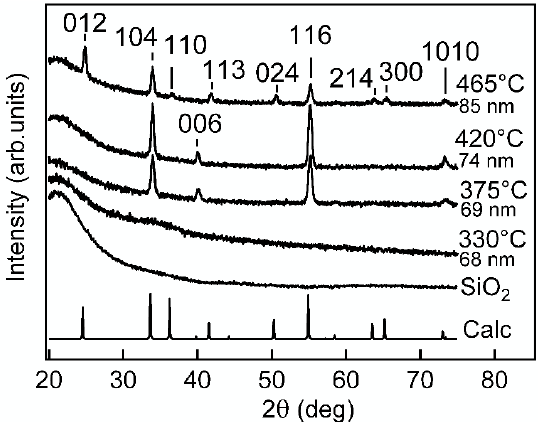
Figure 1. Diffraction patterns of ALD Cr 2 O 3 films grown at different temperatures. The thin film thicknesses were 68–85 nm. The diffraction pattern denoted as Calc was calculated from crystal structure data of eskolaite corresponding to the inorganic crystal structure database collection code 261801. The labels at the reflections are the Miller indices of corresponding lattice planes.